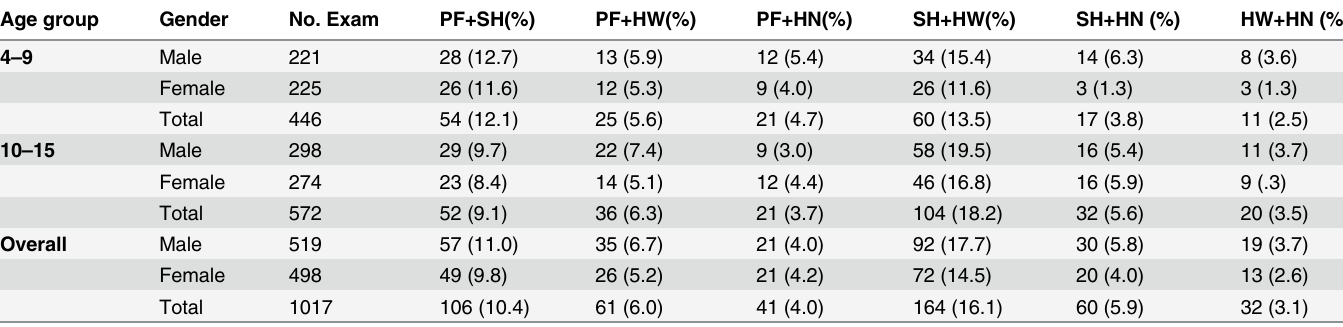
Table 4. Prevalence of children infected with double infection by age and sex. Age